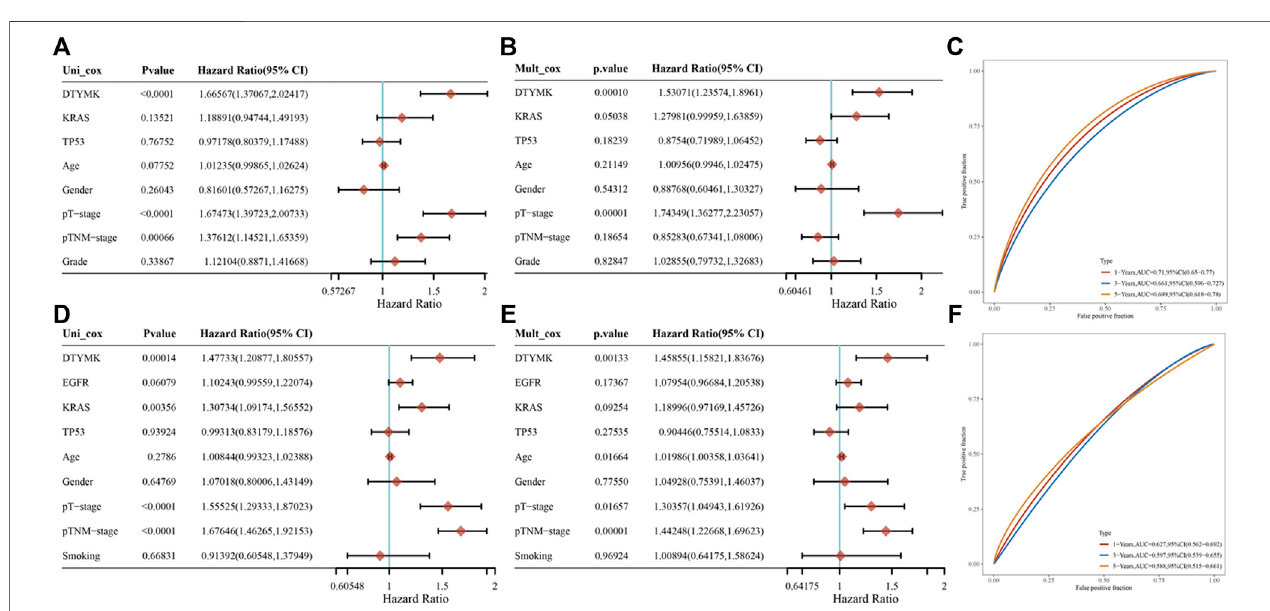
FIGURE 12 | Prognostic function of DTYMK in LIHC and LUAD. Univariate Cox analysis of DTYMK expression and clinical parameters of LIHC (A) and LUAD (D) . Multivariate Coxanalysis ofDTYMK expression and clinical parameters ofLIHC (B) and LUAD (E) .The time-dependent receiver operating characteristic (ROC) and area under the curve (AUC) of DTYMK for LIHC (C) and LUAD (F) .